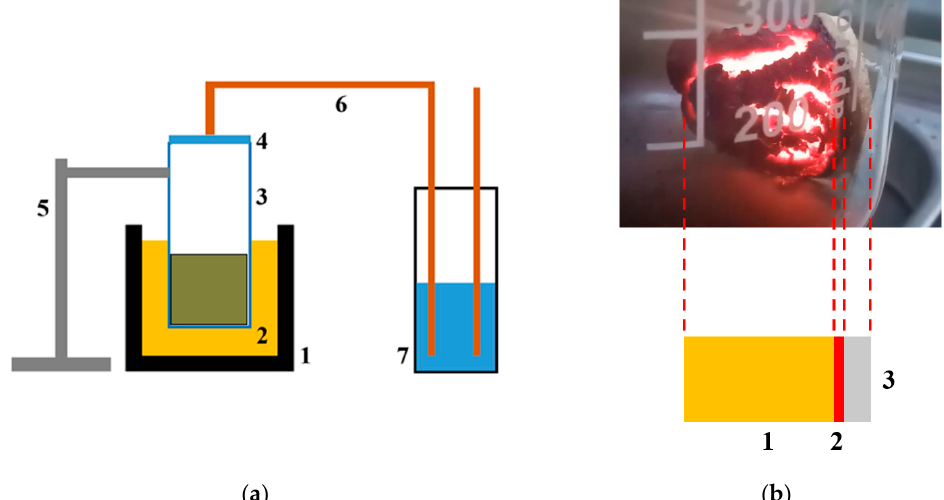
Figure 2. Schematic representation of the setup for SHS ( a ) and the course of the SHS process ( b ). ( a ): 1—oil bath, 2—PVA-300 oil, 3—reactor with charge, 4—reactor cover, 5—tripod-holder, 6—gas exhaust system, 7—water filter. ( b ) The front of the wave of the SHS process is visible, 1—reacted mixture (product), 2—reaction zone (SHS wavefront), 3—unreacted mixture (initial charge). The main feature of carbonization in the process of rapid pyrolysis (a technique usu ‐ After the completion of the SHS process, a black powder was obtained. The ally used for the carbonization of plant polymers) is that fast pyrolysis is carried out dur ‐